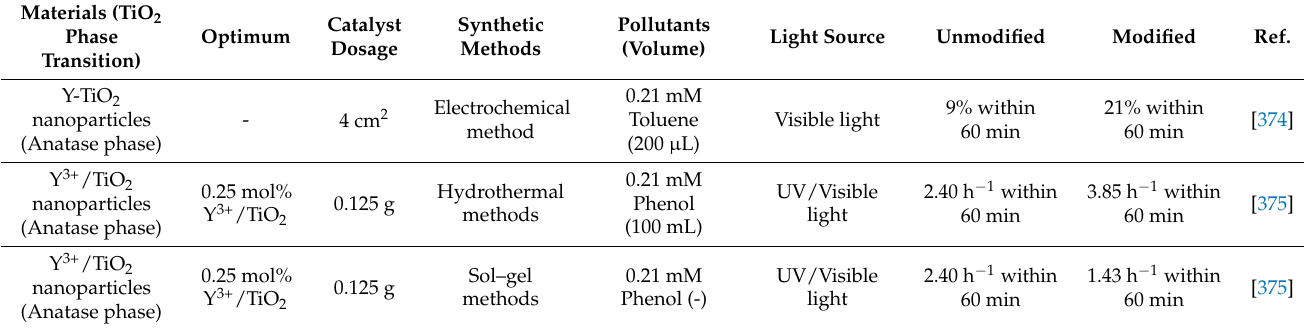
Table 20. Summary of recent progress on Y-TiO 2 photocatalysts for organic pollutants